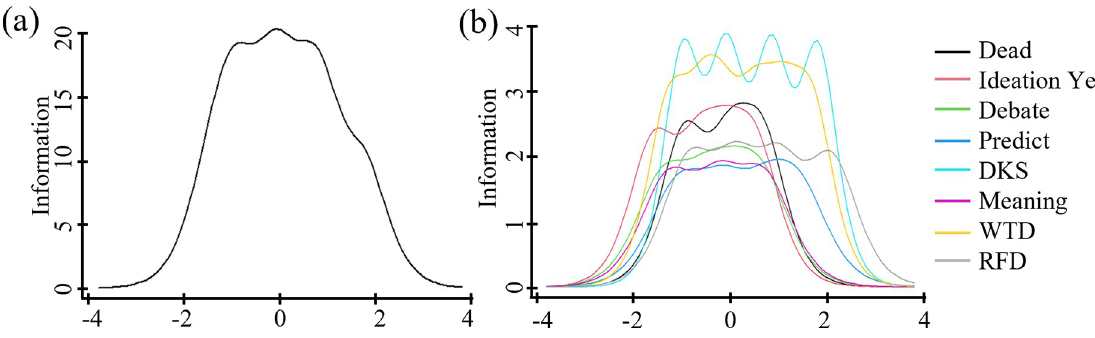
Fig 1. Suicidality Scale test information (left) and item information curves (right).